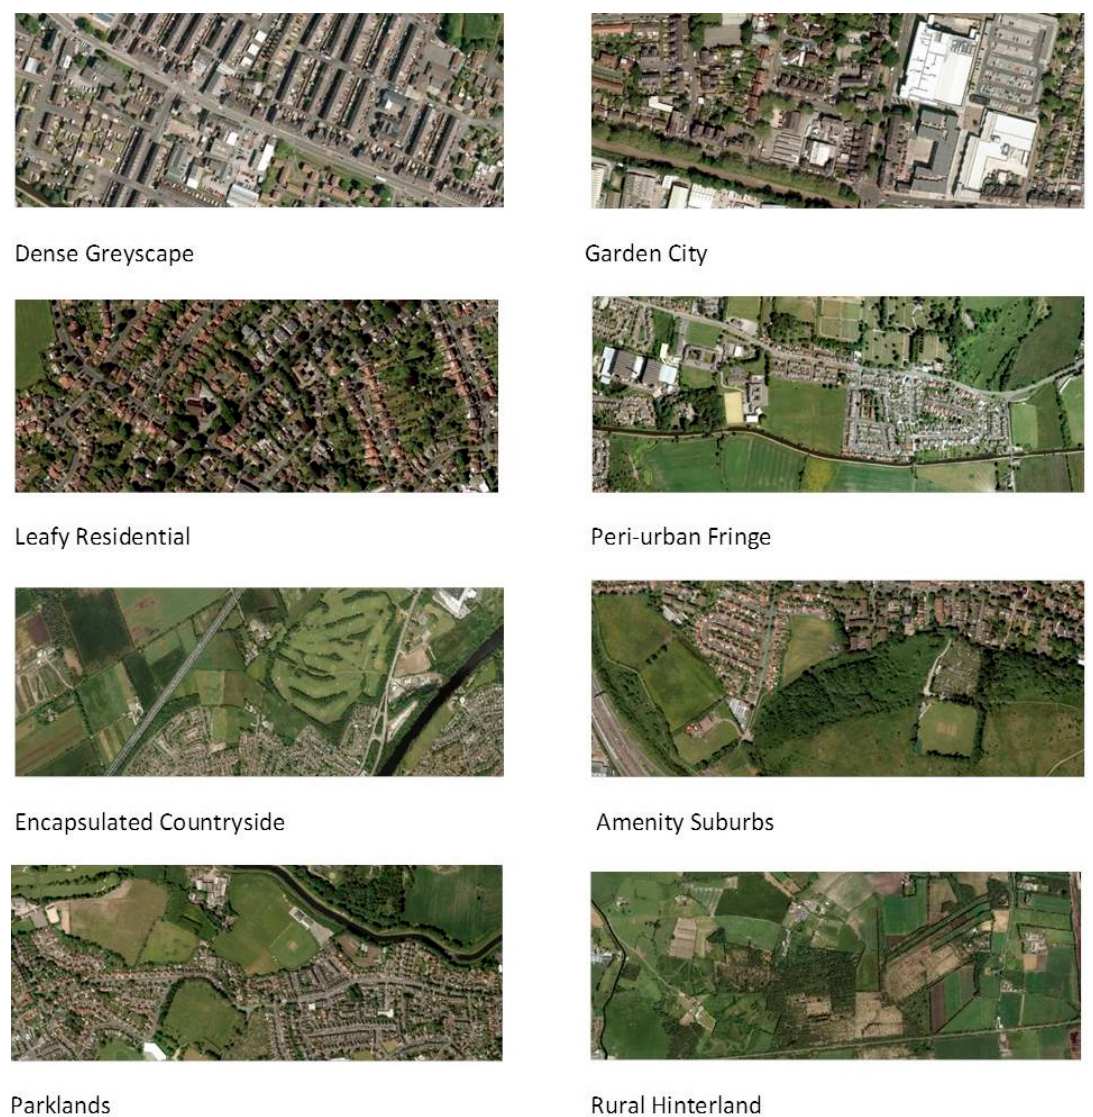
Figure 9. The eight landscapes types resulting from the case study area with indicative labels based on the characteristics in Table 4 (Edina, 2017).